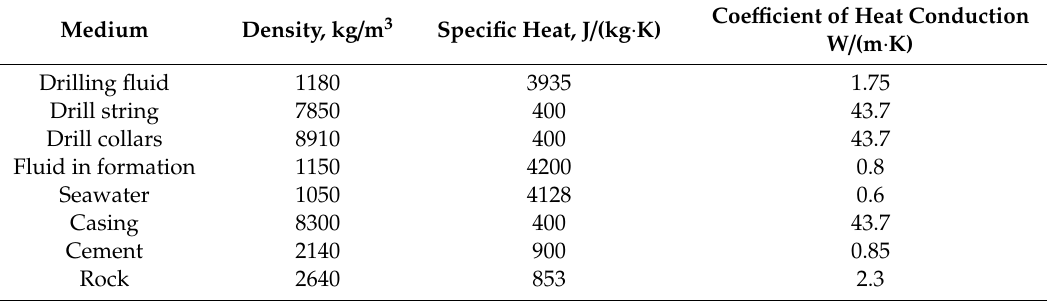
Table 2. Thermo-physical parameters of di ff erent materials or fluid.